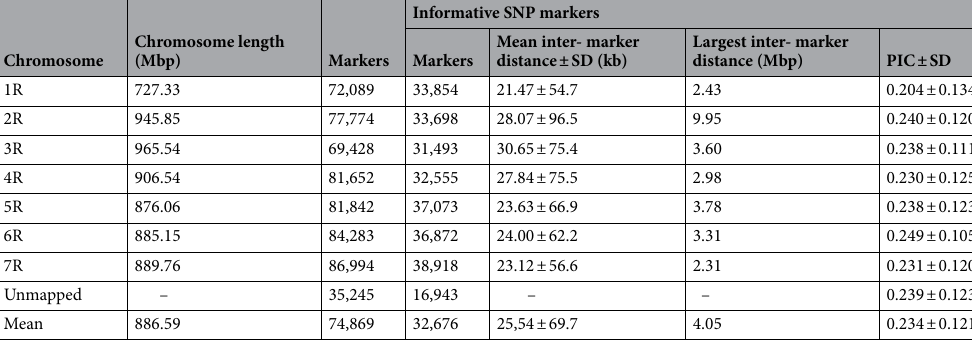
Table 2. Characteristics of informative 600 K SNP array on the Nordic Seed hybrid rye ( Secale cereale L.) elite breeding germplasm (n = 180). Markers were positioned on the ‘Lo7’ reference genome. SD: Standard deviation, PIC: Polymorphism information